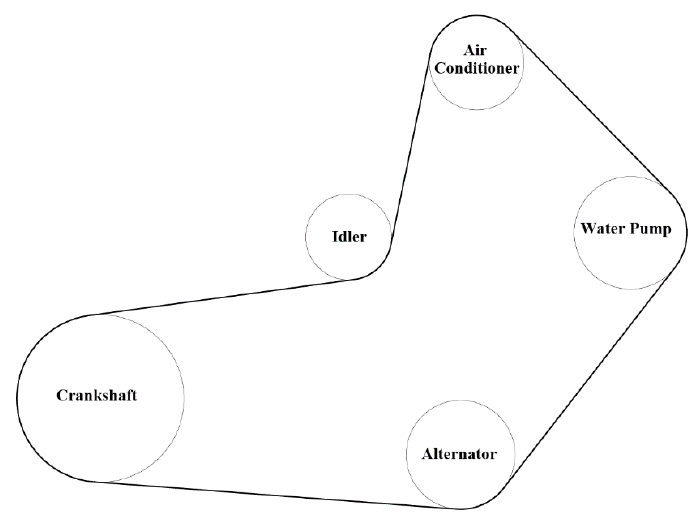
Figure 1. Schematic of a serpentine belt drive system.